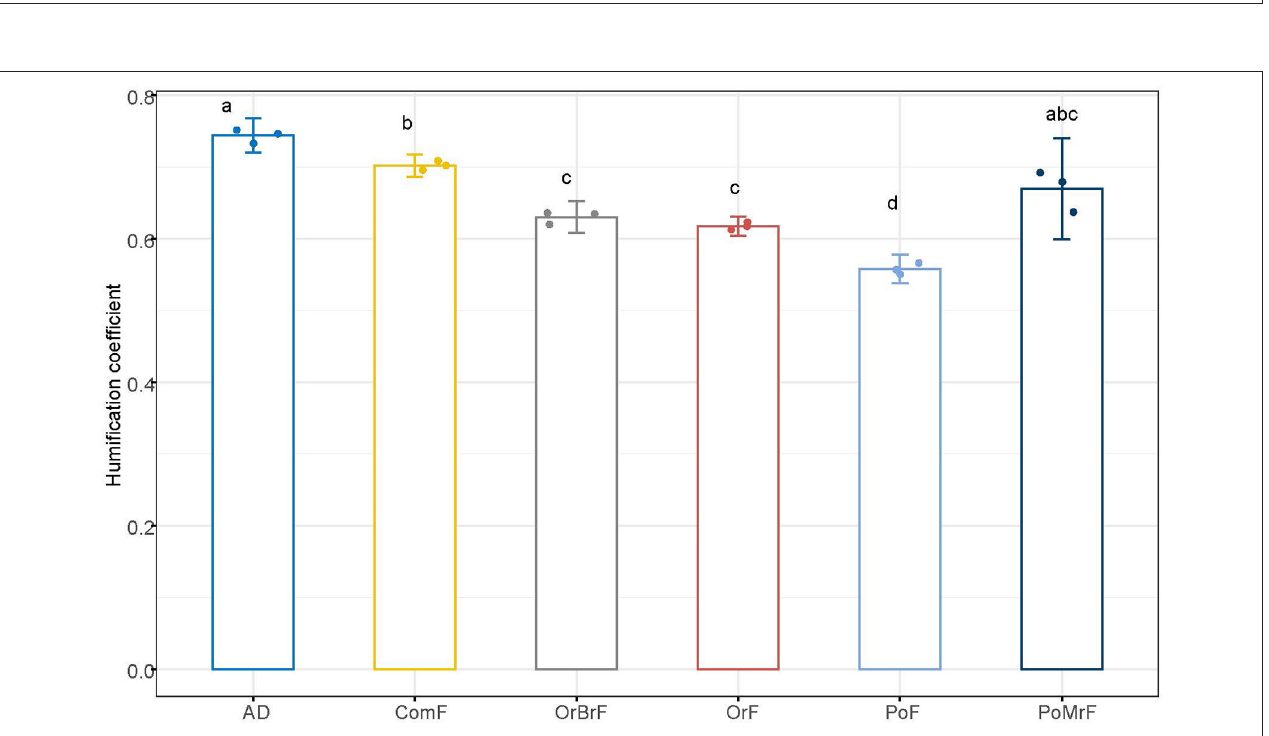
FIGURE 2 | Simulated humification coefficient referring to the fraction of stable C left in the soil 1 year after the application of bio-based fertilizers under field conditions using the 2nd-order kinetic model. Different letters show significant statistical differences ( p < 0.05) between mean values ( n = 3 ± SE).